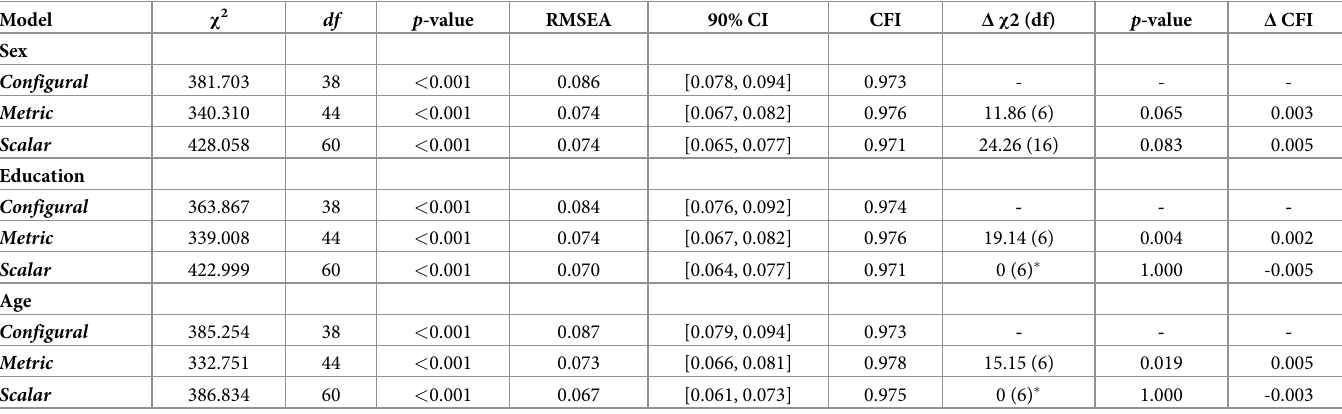
from the metric model ( Δ χ 2 (16) = 24.26; p = 0.083). In other words, factor loadings and thresholds were invariant across men and women. Regarding education, although the config- ural model and scalar model were statistically different ( Δ χ 2 (6) = 19.14; p = 0.004), the fit of the (constrained) metric model improved ( Δ CFI = 0.002) providing evidence of metric invari- ance between those with and without higher education. The same happened when metric invariance was evaluated by age; although the configural model and scalar model were statisti- cally different ( Δ χ 2 (6) = 15.15; p = 0.019), the fit of the metric model ( Δ CFI = 0.005) was Table 4. Measurement invariance according to sex and